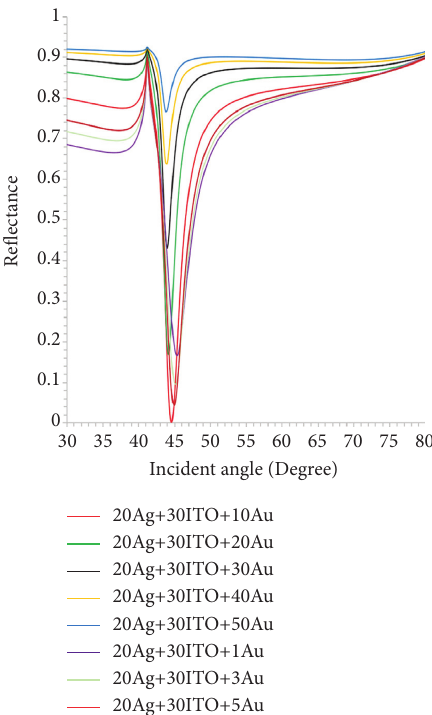
Figure 4: Minimum reflectivity of the sensor when the outermost Au layer thickness changes from 1 to 10 (unit: